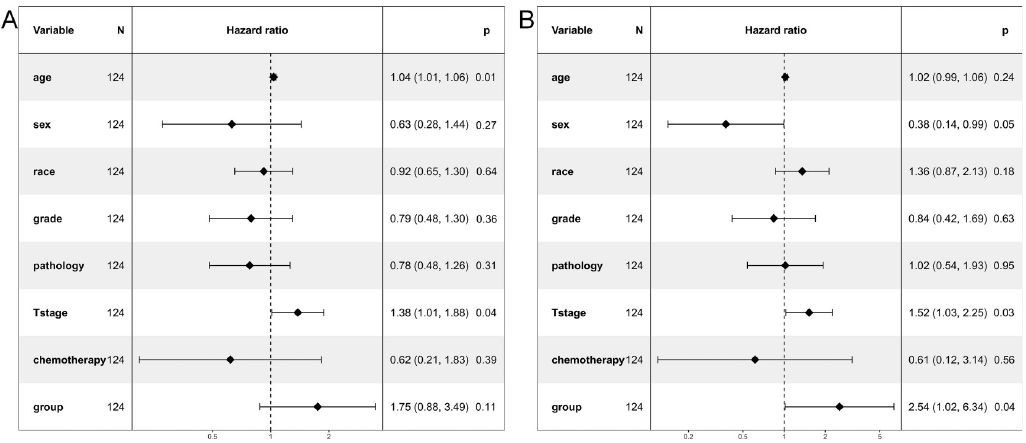
Fig 5. Multivariate regression analysis of prognostic factors for survivals in the propensity-matched cohort. (A) Overall survival. (B) Cancer-specific survival.